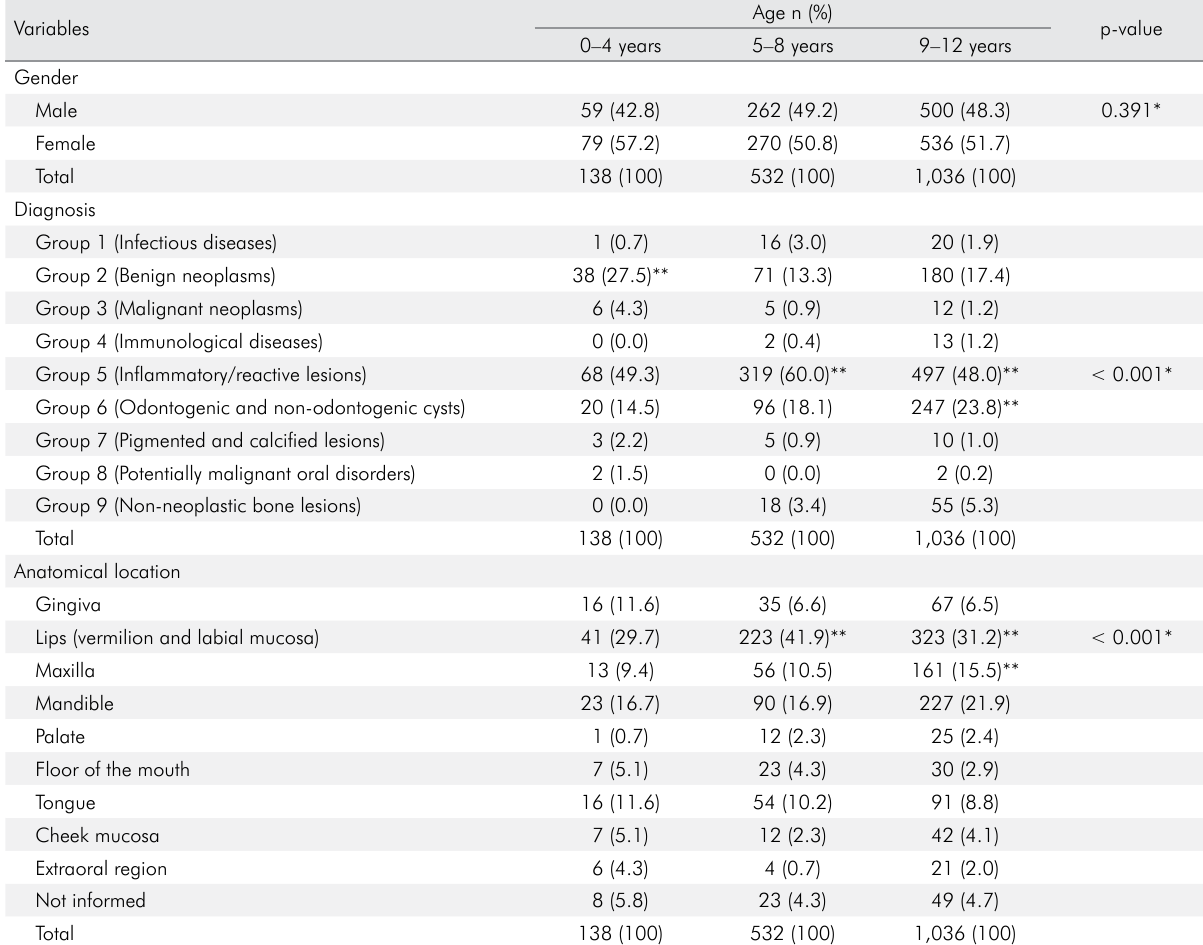
Table 2. Frequency of oral lesions in the pediatric patients studied.